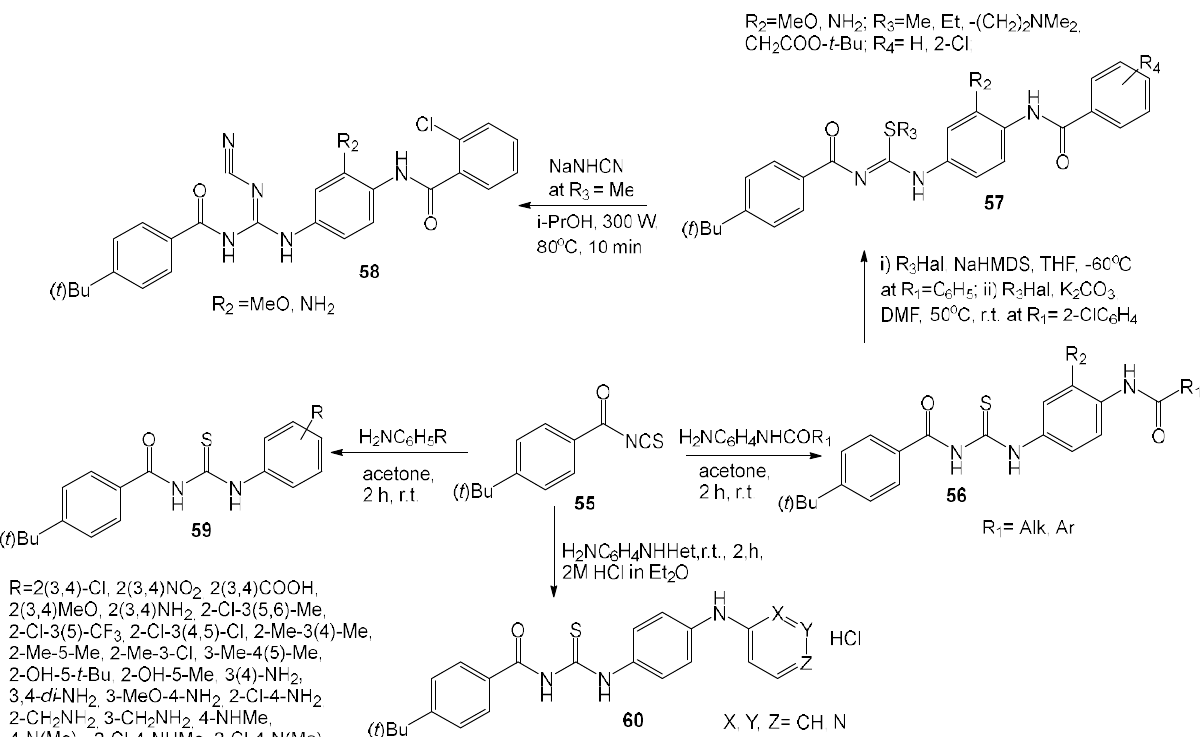
17. Approaches to the synthesis of a combinatorial library of antiviral agents based on 4-(tert-butyl)benzoyl isothiocyanates